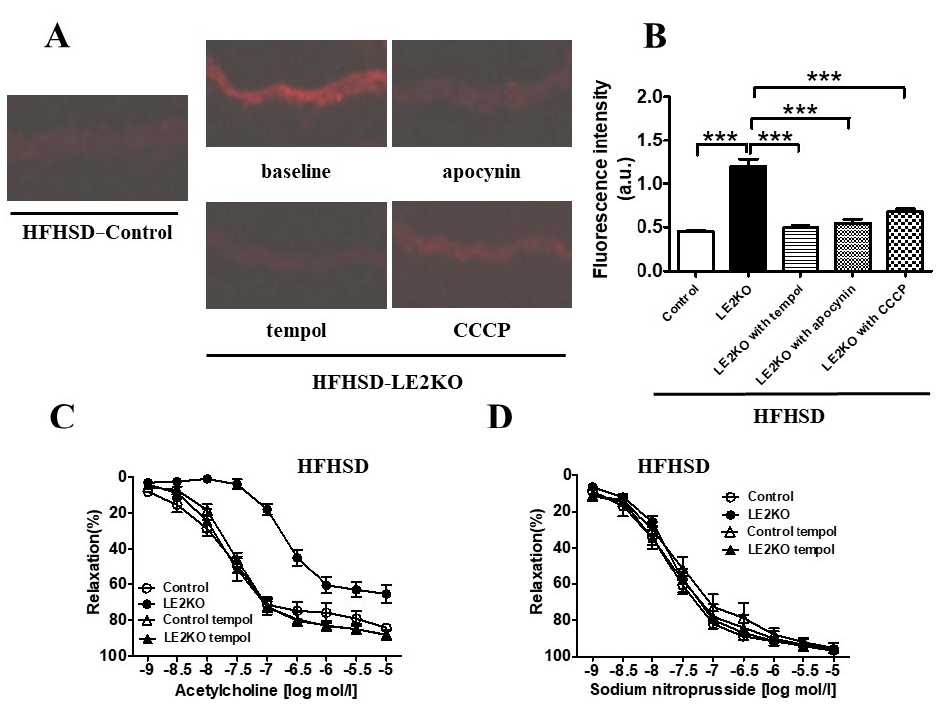
Figure 6. HFHSD-LE2KO demonstrate increased aortic superoxide levels and impaired endothelium-dependent relaxation. ( A ) DHE staining of aorta from HFHFD-Control, HFHSD-LE2KO, and HFHSD-LE2KO with pre-incubated of tempol, apocynin, and CCCP and ( B ) quantification of DHE fluorescence intensity ( n = 5–6 for each group). Vascular relaxation of aortic rings with ACh ( C ) and SNP ( D ) on NC or HFHSD for 20 weeks, respectively ( n = 8–10 for each group). Results of relaxation are expressed as percentage changes in steady-state level of contraction with 10 − 6.5 M phenylephrine. Error bars represent SEM; p values were determined by ANOVA (*** p < 0.001 vs. HFHSD-LE2KO without pre-incubation).